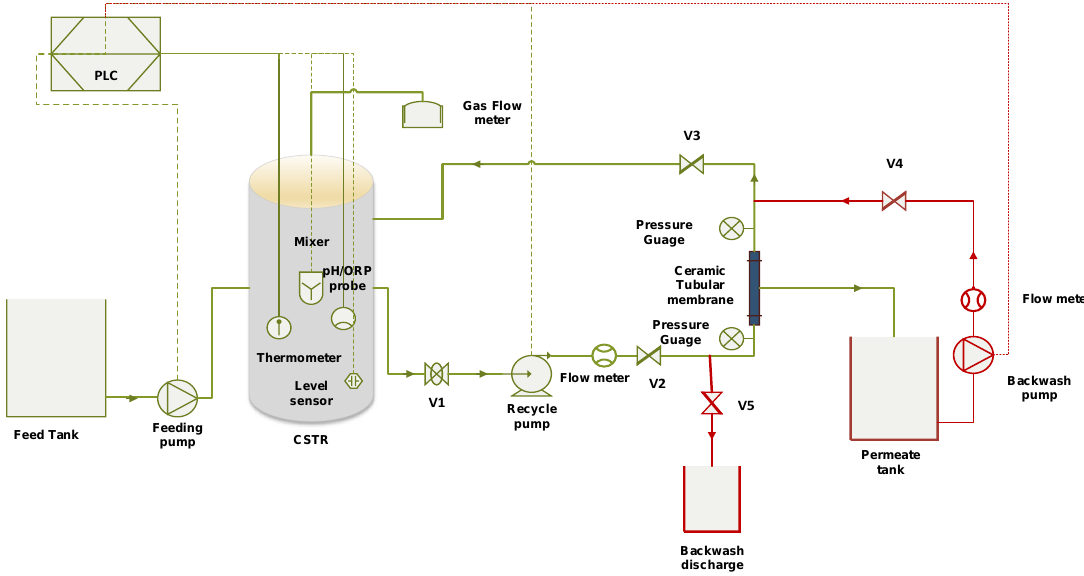
Figure 1. Schematic illustration of the anaerobic membrane bioreactor (AnCMBR) set-up.